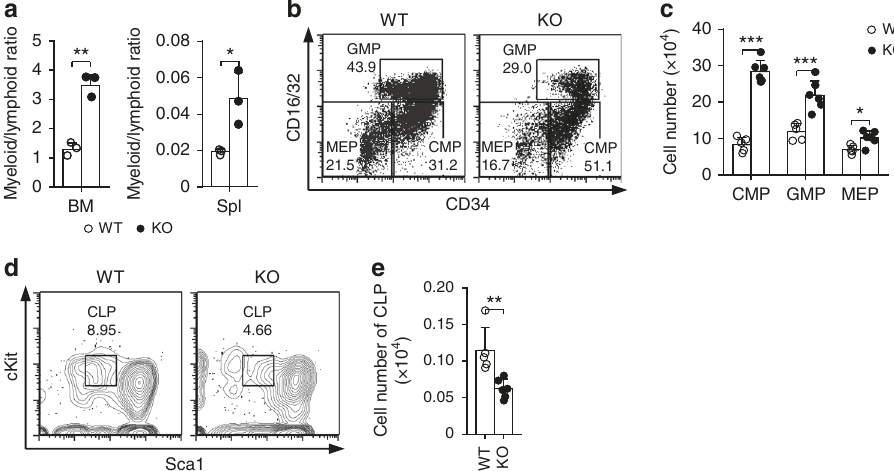
Fig. 2 Loss of Med23 results in increased myeloid progenitors. a The ratio of myeloid cells to lymphoid cells in bone marrows (left) and spleens (right) of WT and KO mice ( n = 3). b , c Representative dot plots Lin − CD127 − cKit + Sca1 − live cells ( b ) and cellularity ( c ) of common myeloid progenitors (CMPs), granulocyte-macrophage progenitors (GMPs) and megakaryocyte/erythroid progenitors (MEPs) in bone marrows of WT and KO mice (WT, n = 5; KO, n = 6). d , e Representative contour plots gating from Lin − CD127 + live cells ( d ) and cellularity ( e ) of CLPs in bone marrows of WT and KO mice (WT, n = 5; KO, n = 6). The data are means ± S.D., for all panels: * p < 0.05, ** p < 0.01, *** p < 0.001 by Student ’ s t